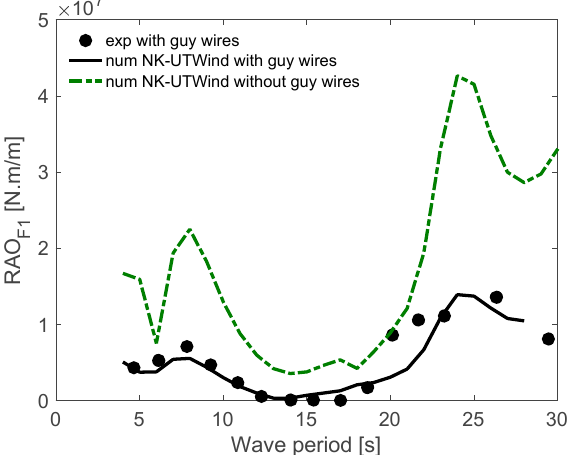
Figure 23. E ff ect of the guy wires on the RAO bending moment at the tower-base gage (F1), and its comparison between the experiment and calculation.